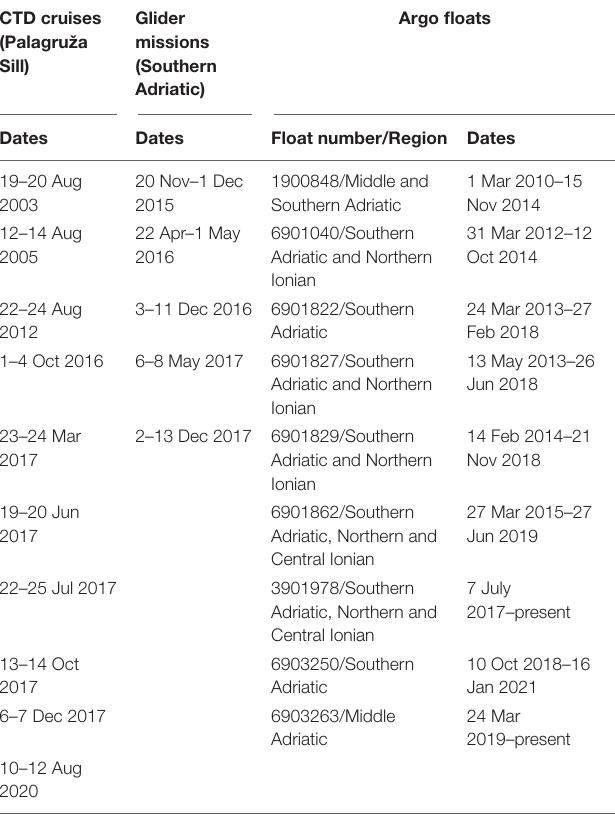
TABLE 1 | The list of CTD cruises (Palagruža Sill), glider missions (Southern Adriatic), and Argo profilers (Northern and Central Ionian Sea, Middle and Southern Adriatic) presented in the study, including their deployment